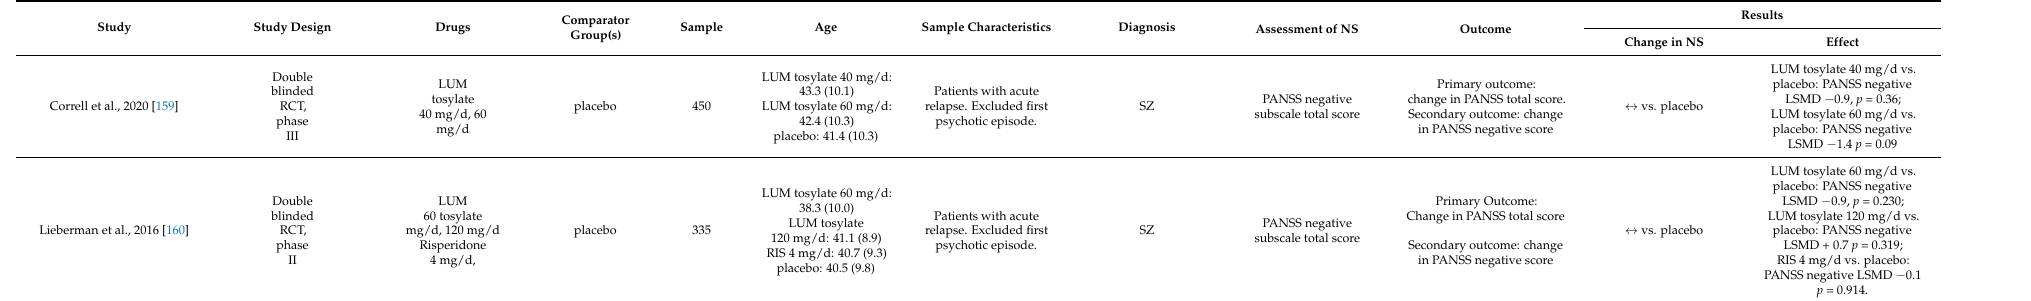
Table 5. Studies on the efficacy of lumateperone in the treatment of negative